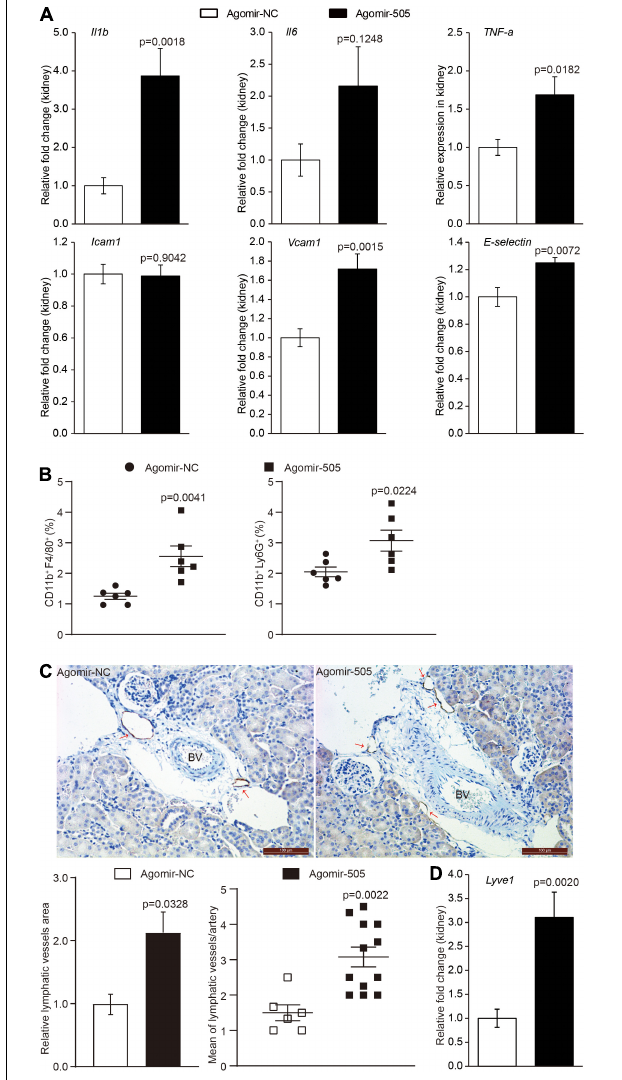
FIGURE 3 | Elevated circulating level of miR-505 results in renal inflammation. Agomir-505 or agomir-NC was intravenously administered for 2 weeks. One week after the last injection, the kidneys were dissected, followed by gene expression or flowcytometry analyses. (A) Real-time qPCR analysis was performed to examine the renal expression of Il1b , Il6 , TNF-a , Icam1 , Vcam1 and E-selectin in agomir-505-treated ( n = 8) or agomir-NC-treated mice ( n = 8). Relative fold change of the expression of the indicated genes was plotted against that from agomir-NC-treated mice. Data represent mean ± SEM. P values are derived from the Student’s t -test. (B) Flowcytometry analysis was performed to quantify the number of CD11b + F4/80 + macrophages or CD11b + Ly6G + neutrophils in the kidneys from agomir-505-treated ( n = 6) or agomir-NC-treated mice ( n = 6). Data represent mean ± SEM. P values are derived from the Student’s t -test. (C) Agomir-505 or agomir-NC was intravenously administered for 2 weeks. Two weeks later, the kidneys were dissected, followed by immunohistochemical examination and gene expression analyses. Immunohistochemistry was performed to visualize the lymphatic vessels in the kidneys from agomir-505-treated mice ( n = 12) and agomir-NC-treated mice ( n = 6). Lyve-1 positive area and the number of Lyve-1 positive lymphatic vessels (red arrows) around the interlobular arteries (BV) in the kidney were